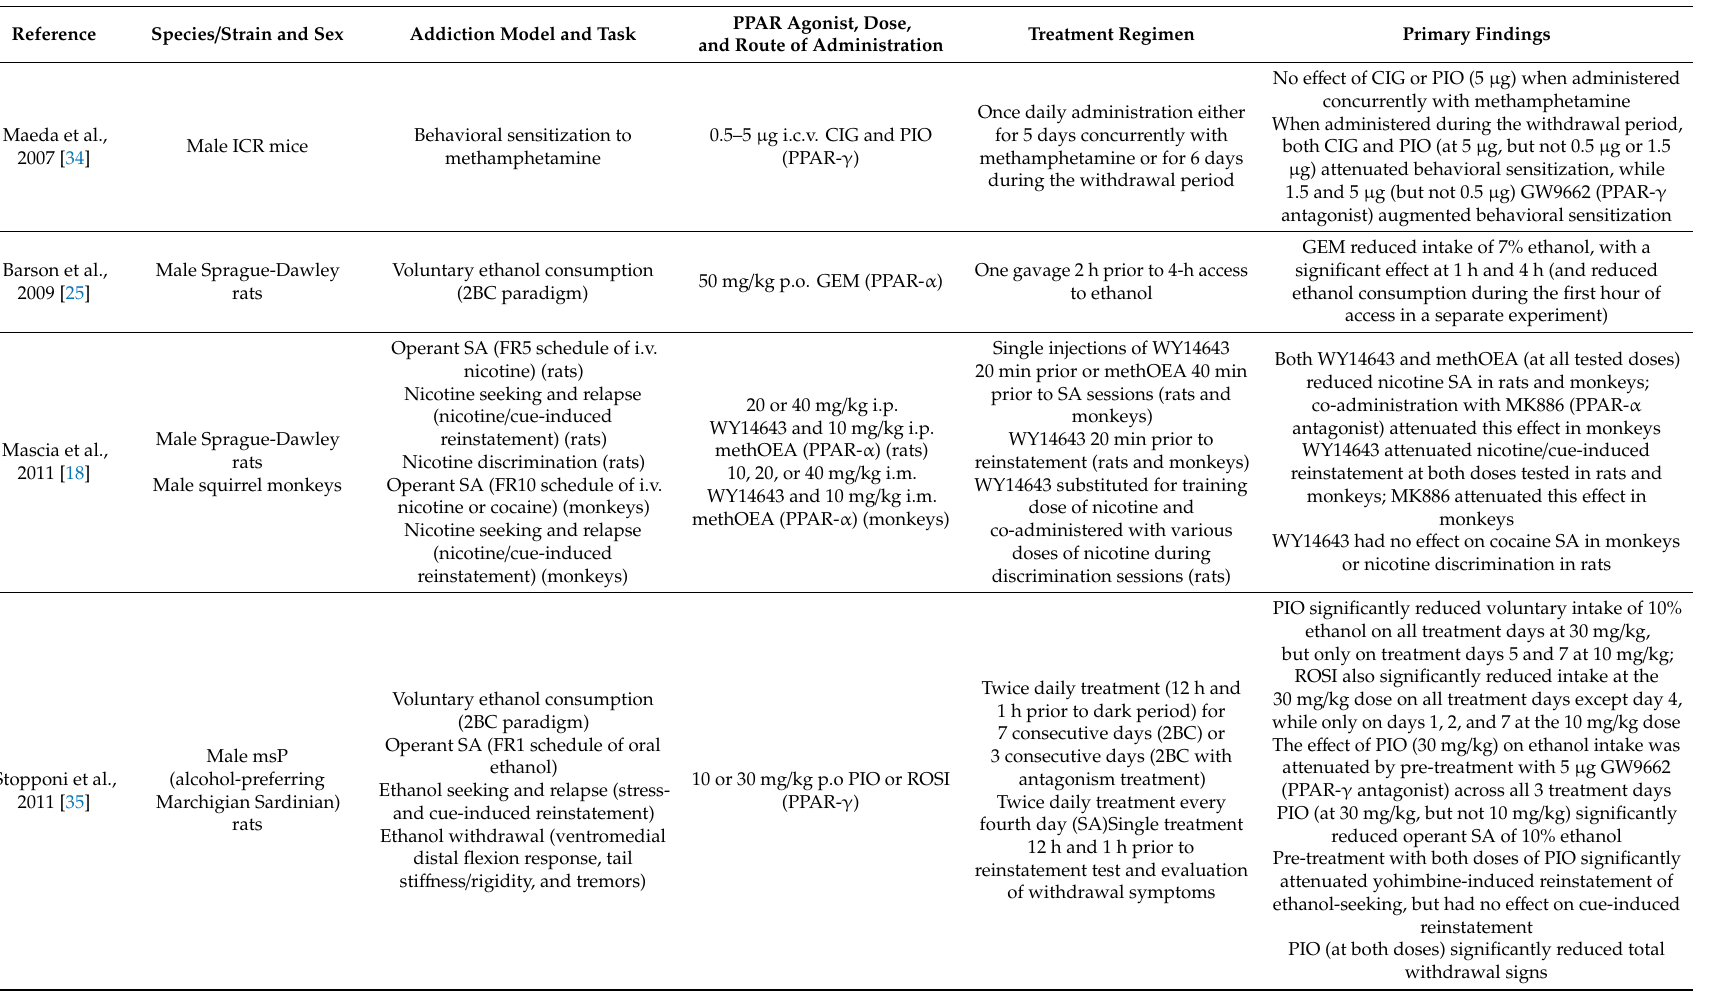
Table 1. Overview of methodological details and primary findings of the key studies providing behavioral evidence for a role of PPAR agonists in modulating addiction-related behaviors in animal